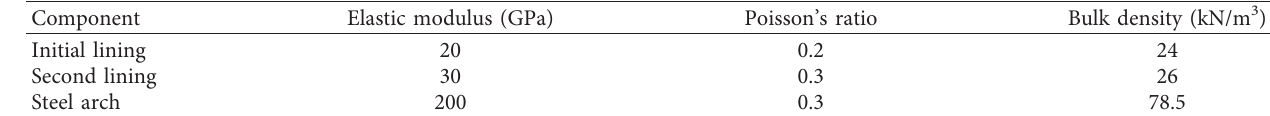
Table 2: Structural parameters.